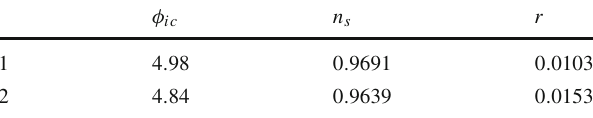
Table 1 Initial conditions for the effective scalar potential in Eqs. (3.2) and (3.5) and the predictions for n s and